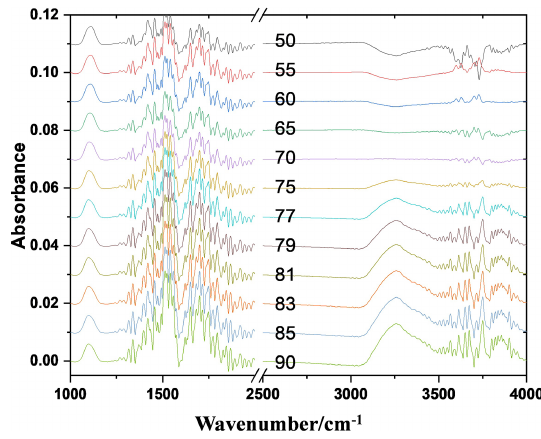
Figure 2. FTIR spectral characteristics of the AS nanoparticles un- der humidity conditions from 50% to 90% (RH).